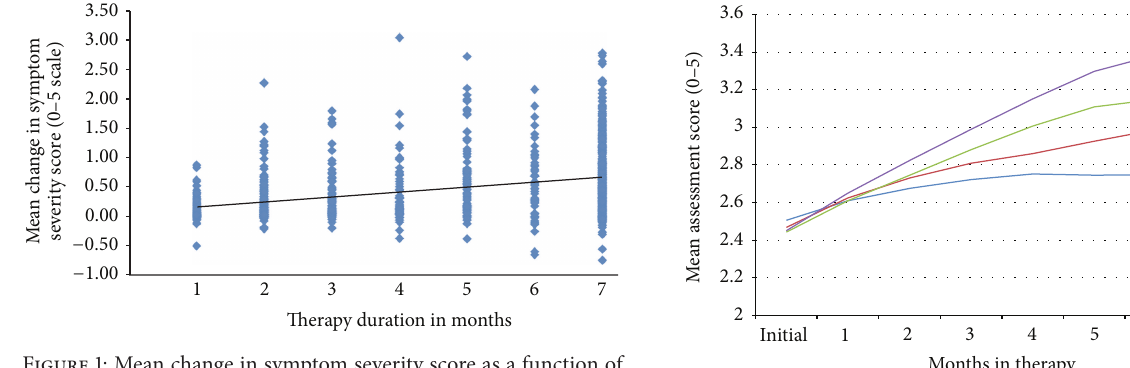
Figure 1: Mean change in symptom severity score as a function of therapy duration in months ( R 2 = 0.14). Symptom severity score was the change on a 0–5 scale for all answered questions for each subject.